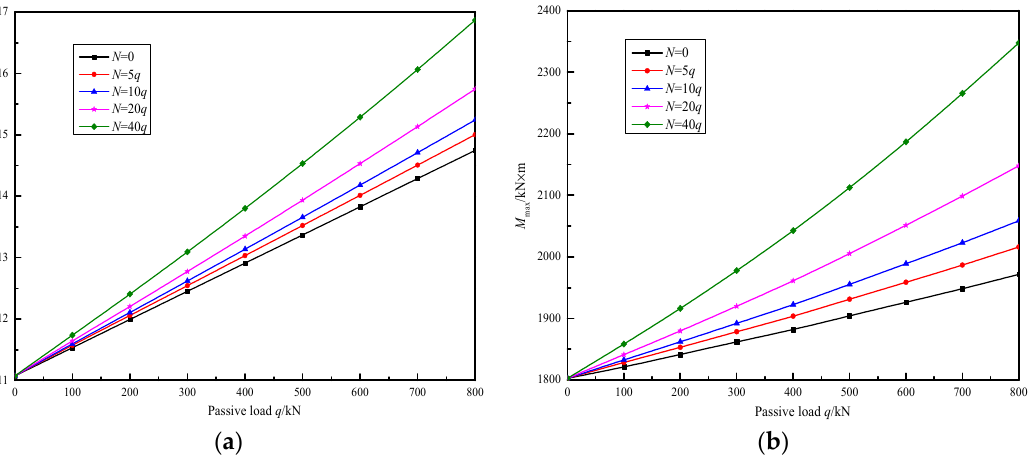
Figure 16. Influence of passive load on lateral behavior of pile shaft under different load ratios. ( a ) Maximum lateral displacement. ( b ) Maximum bending moment.